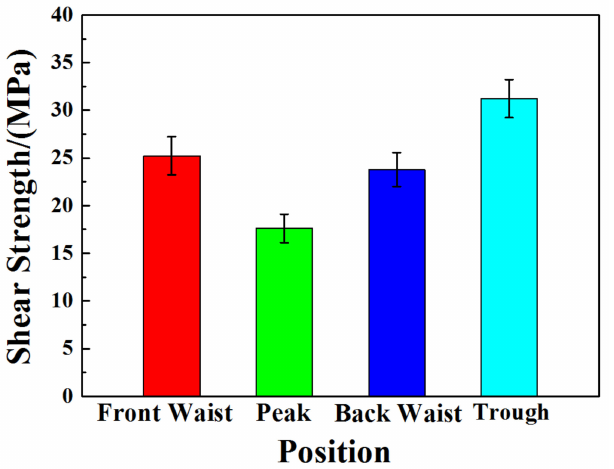
Figure 8. Transverse tensile-shear strength at four positions of the corrugated Mg/Al clad